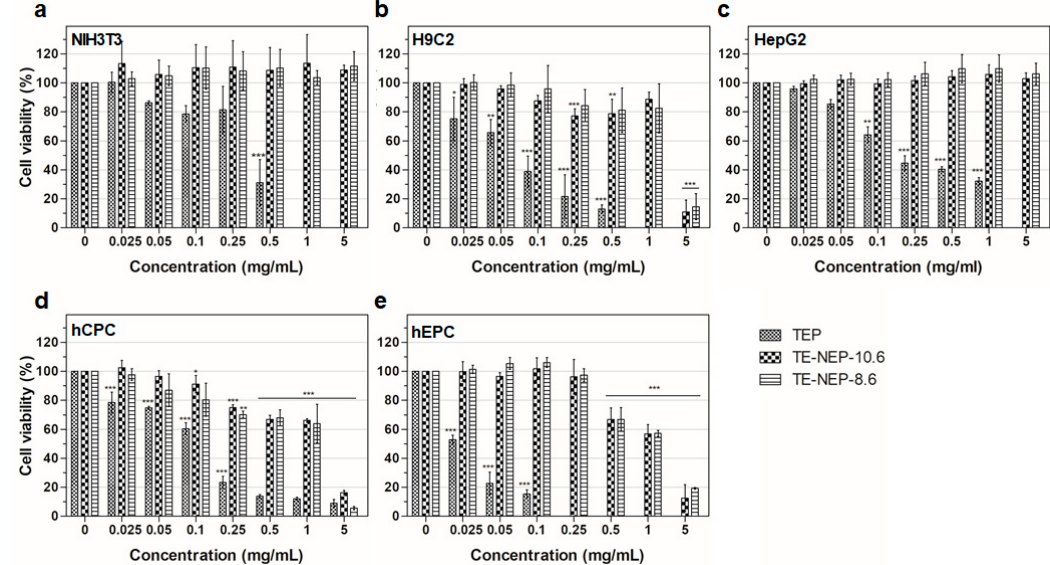
Figure 2. Evaluation of cell viability by MTT assay on ( a ) NIH3T3 cell line, ( b ) H9C2 cell line, ( c ) HepG2 cell line, ( d ) hCPC primary cell, ( e ) hEPC primary cell treated with Turmeric extract powder (TEP) and turmeric extract-loaded nanoemulsion powder with HLB values of 10.6 (TE-NEP-10.6) and 8.6 (TE-NEP-8.6), respectively. Cells were incubated with nanoemulsion samples (0.025, 0.05, 0.1, 0.25, 0.5, 1 and 5 mg/mL) for 24 h. Experiments were repeated 3 times independently. *, **, *** p < 0.05, compared to the